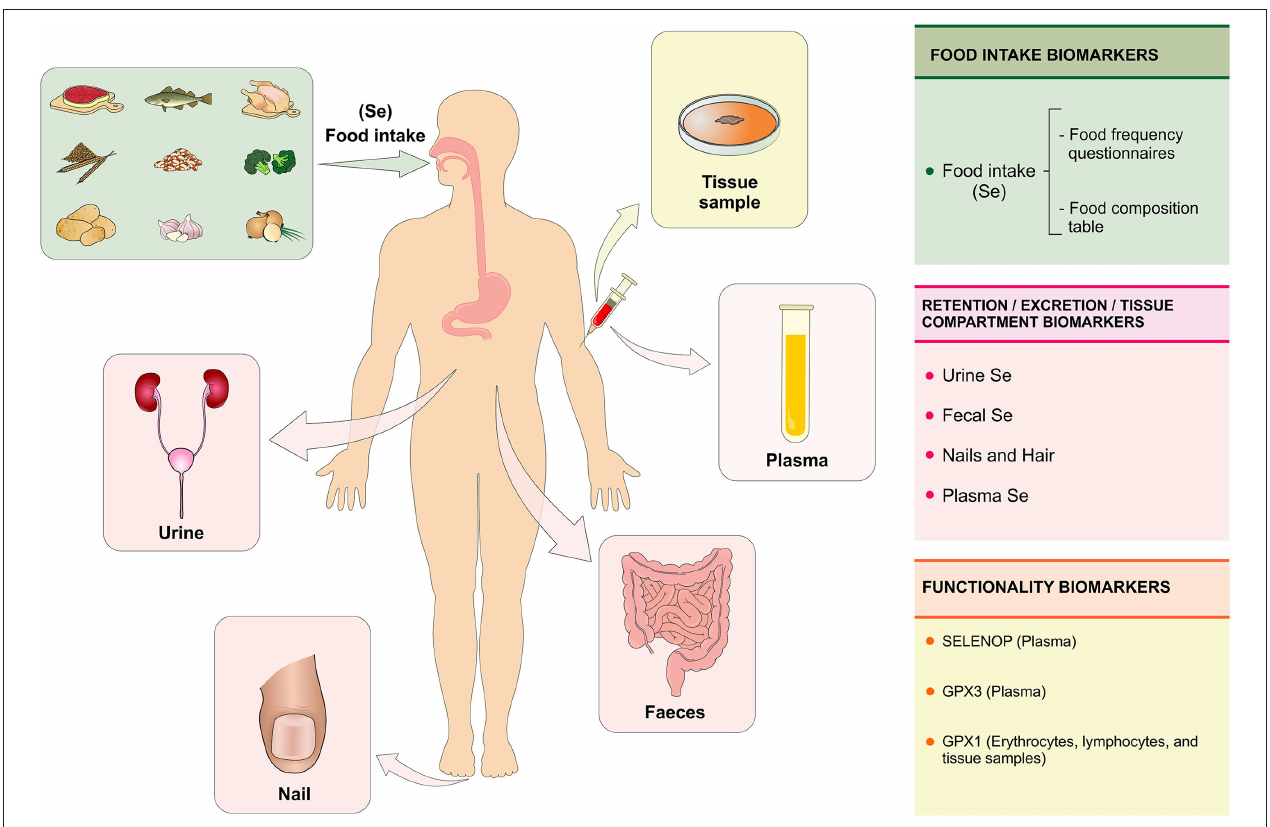
FIGURE 4 | Se biomarkers. The Se status is evaluated with the purpose of quantifying the biologically active or potentially active nutrient as a function of Se intake, retention, and metabolism in the body. The Se status can be assessed at three levels using specific biomarkers: (1) biomarkers of intake (assessment of food consumption through the food frequency questionnaire); (2) biomarkers of retention/excretion and concentration in tissues (urine, feces, nails, hair, and plasma) and (3) biomarkers of selenium functionality (SELENOP and GPX3 in plasma and GPX1 in erythrocytes, lymphocytes, and tissue samples). Se, selenium; SELENOP, selenoprotein P; GPX1, glutationa peroxidase; GPX3, glutationa peroxidase 3 (Figure illustration by Francisco Irochima